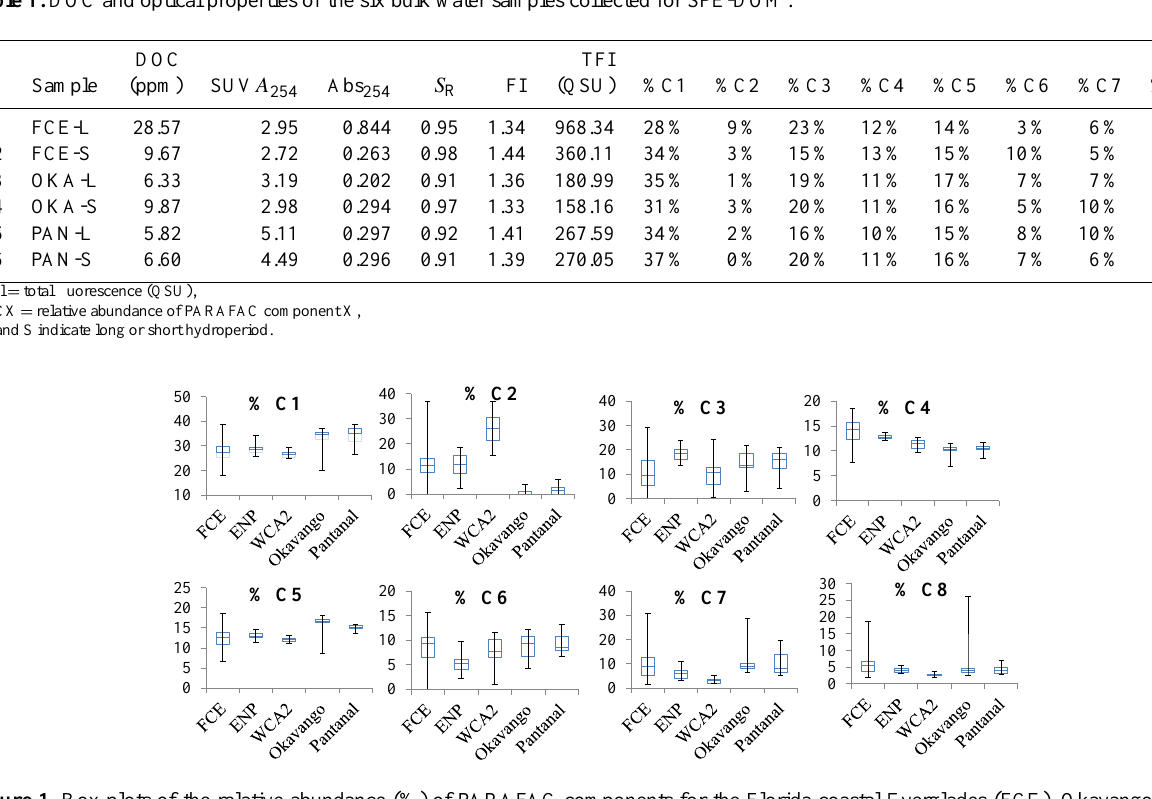
Table 1. DOC and optical properties of the six bulk water samples collected for SPE-DOM.